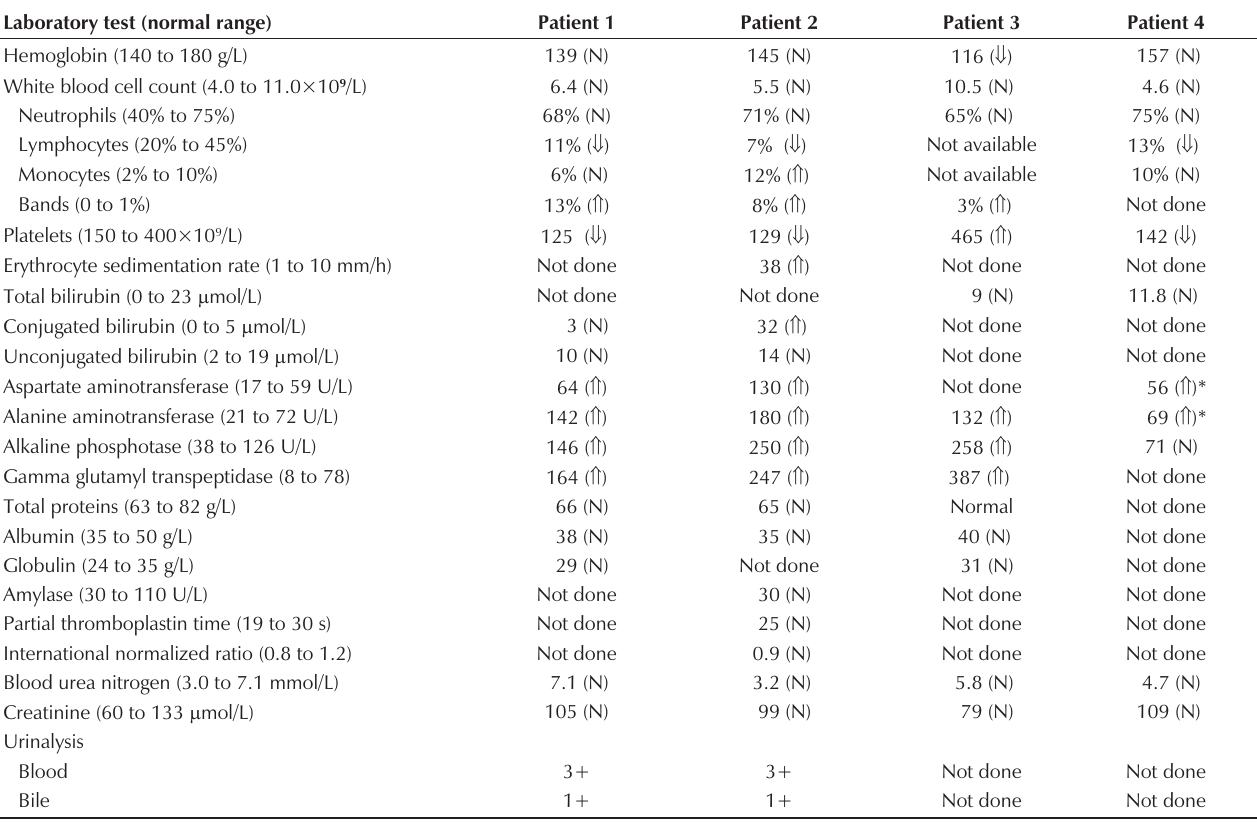
Results of hematological, biochemical and urinalysis laboratory tests of four patients with suspected leptospira infection Laboratory test (normal range)